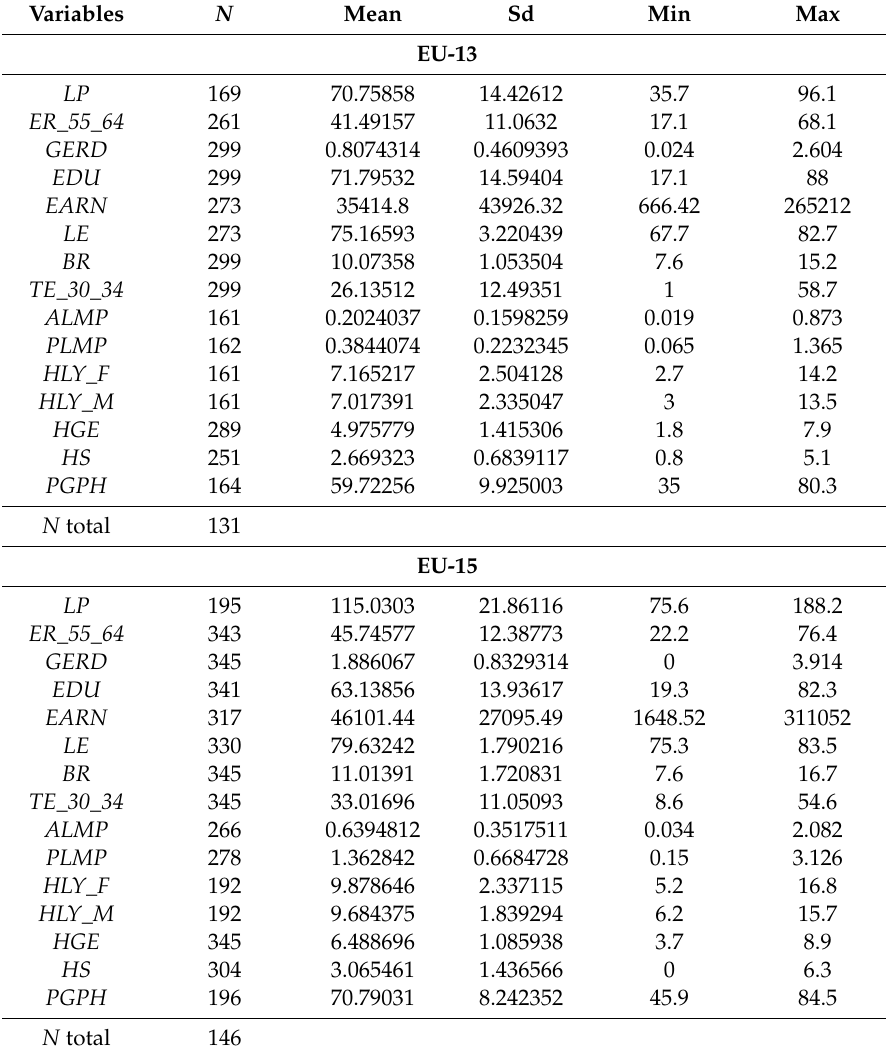
Table A1. Summary statistics for the EU-28,